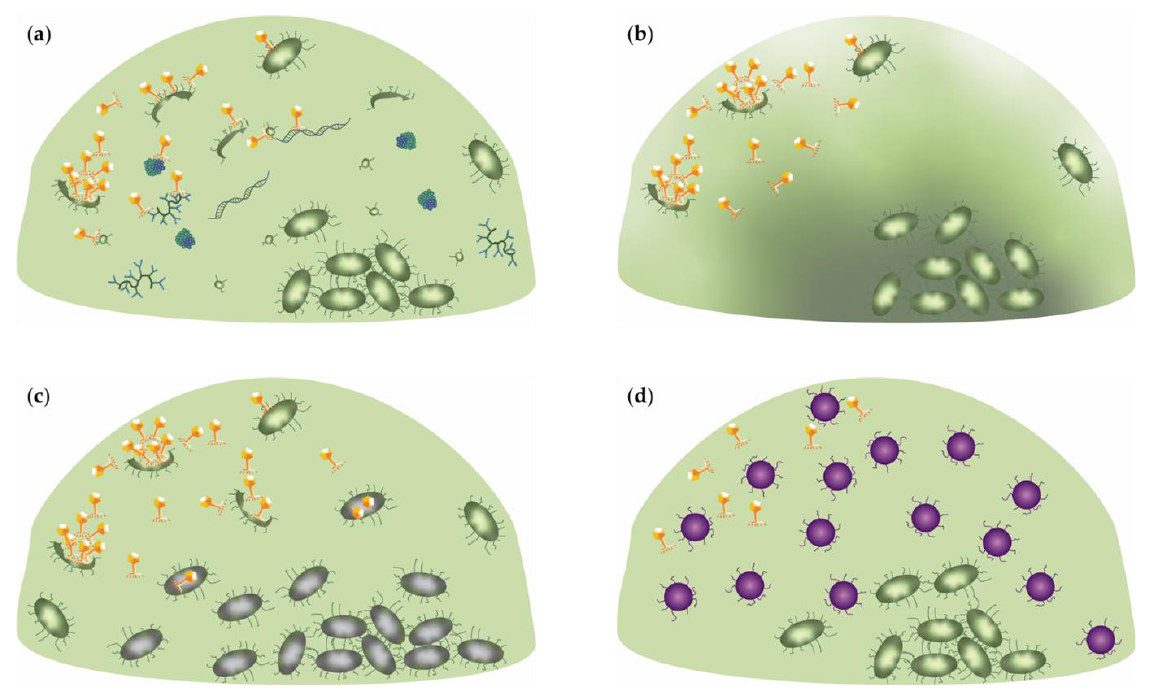
Figure 1. Biofilm defense mechanisms against phage predation: ( a ) Absorption traps . The biofilm matrix can contain several absorption traps for phages, including dead cells, vesicles andin various macromolecules (in blue) recognized by the phage particles; ( b ) Diffusion inhibition. Bulk flow is restricted in the biofilm environment due to the presence of the extracellular matrix and high cell densities. Therefore, diffusion becomes the main transport mechanism of solutes in the biofilm environment, which is much slower. Phages can infect the cells that are close to the surface, but reach the dense bacterial clusters that are surrounded by the thick layer of the extracellular matrix (gradient background) much more slowly; ( c ) Metabolic refuges . Phage replication efficacy depends on the host’s metabolic state. Cells deep within the biofilm and in the bacterial clusters have low metabolic activity (grey colored cells), hence phage replication in these cells is inhibited. Cells that are deep within the biofilm or at the center of the bacterial clusters will not be reached by phage progeny because phage proliferation is inhibited by the metabolically less active neighboring cell; ( d ) Wall effect . The interior-located non-resistant bacteria (green) are protected from phage predation by phage-resistant bacteria (purple). The phage-resistant bacteria form a protective shield around non-resistant bacteria and hence, phage exposure will not eliminate its host.